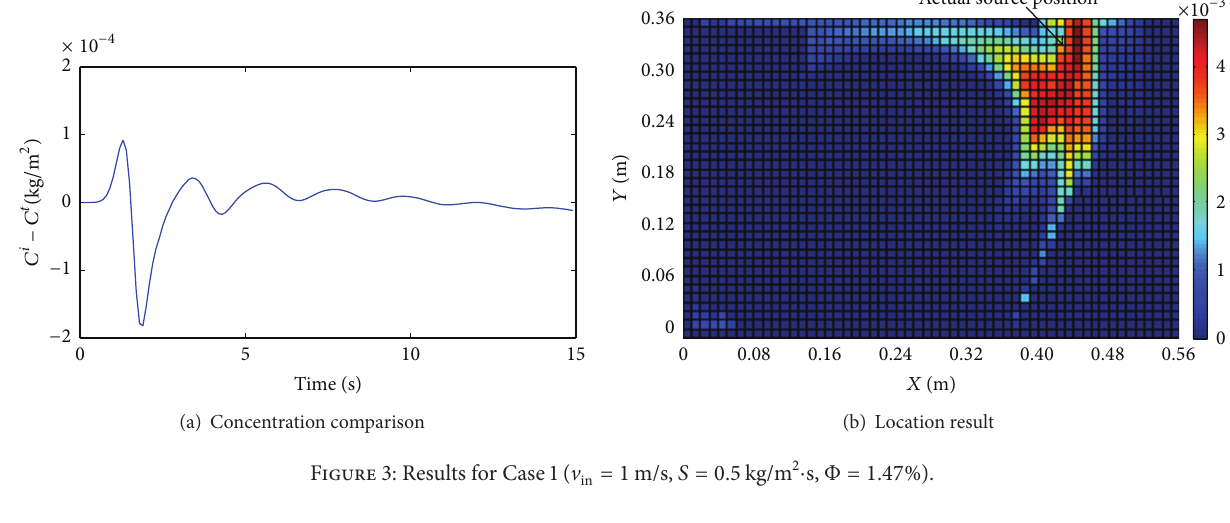
Figure 3: Results for Case 1 ( V